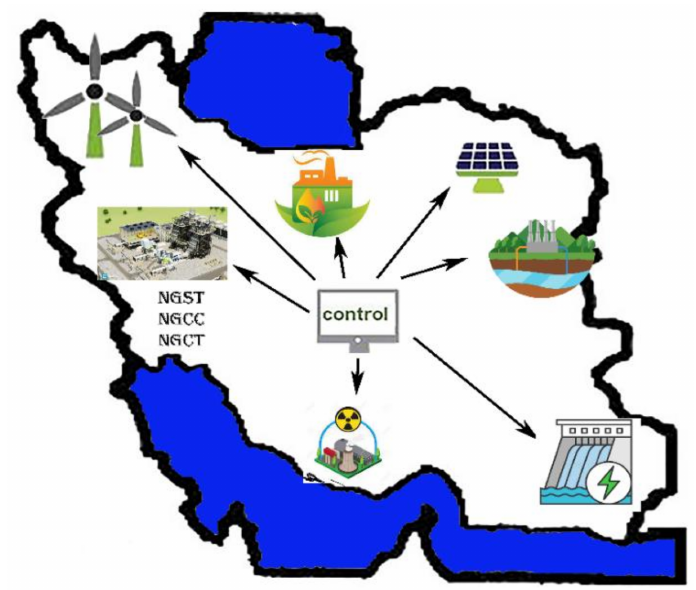
Figure 1. A schematic of regarded power plants in a case study of